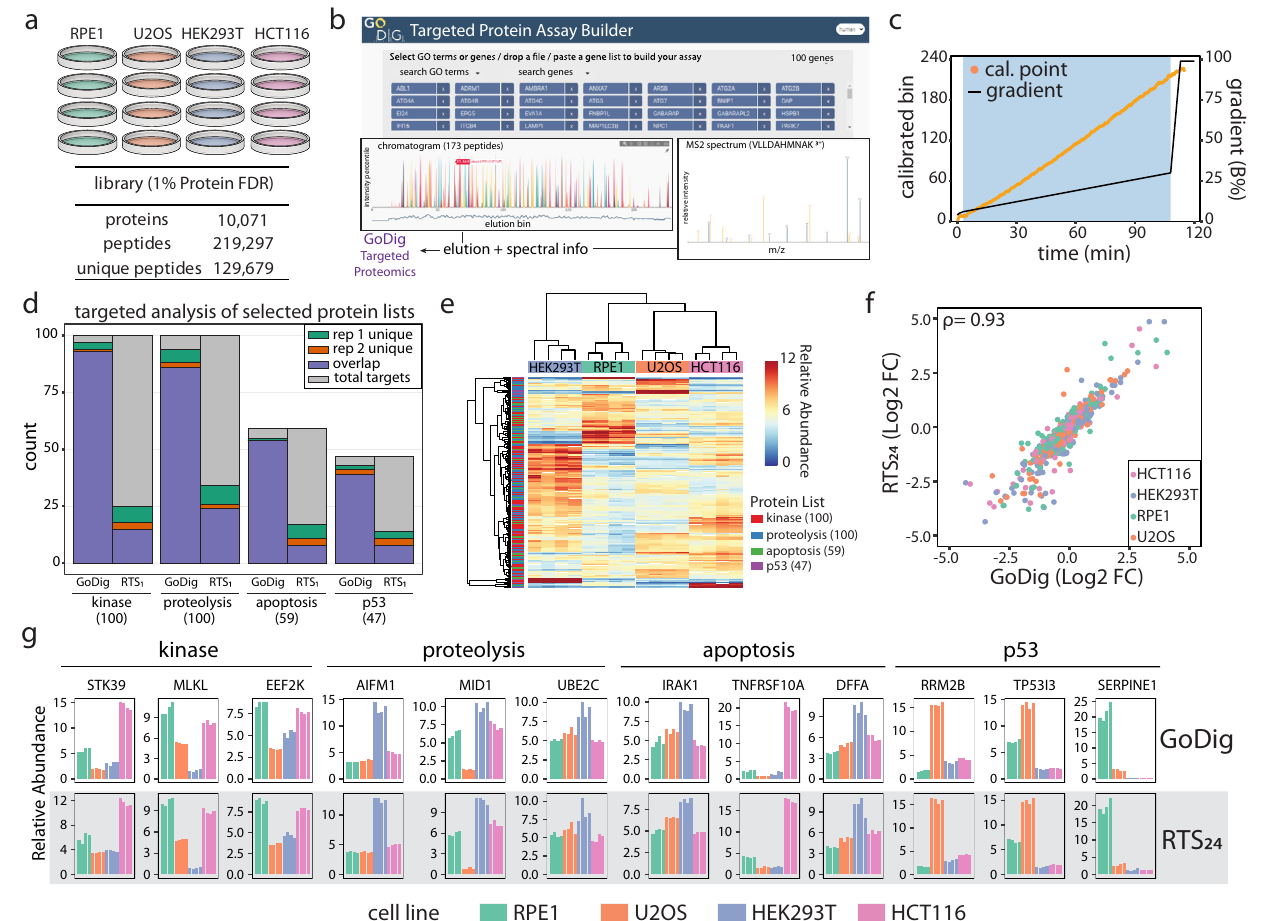
Fig. 2 | Accurate and complete pro fi ling of protein families via GoDig. Over- view:TodemonstratethatGoDigmaybeusedtoquantifyarbitraryproteinfamilies with high accuracy and coverage, we targeted proteins from four representative families for quanti fi cation across human cell lines ( a – c ). High coverage was achieved across all four families ( d ) and signi fi cant variations in abundance were observed across cell lines for each protein family ( e ). Quantitative pro fi les were consistentbetweenmethodologies( f , g ),withGoDigperformanceequivalentto,if not better than, that achieved via RTS with fractionation. a Biological quad- ruplicates of RPE1, U2OS, HEK293T, and HCT116 were processed and labeled with TMTpro16.Toconstructthelibrariesforelutionpredictionandspectralmatching, 24fractionsweregenerated,andeachwasanalyzedwitha2-hgradient.Thelibrary consistedofmorethan10,000targetableproteins. b GoDigtargetedproteinassay website (http://caribou.med.harvard.edu/godig/) was used to construct different protein assays. Input can be either gene symbols or entire pathways (e.g., GO